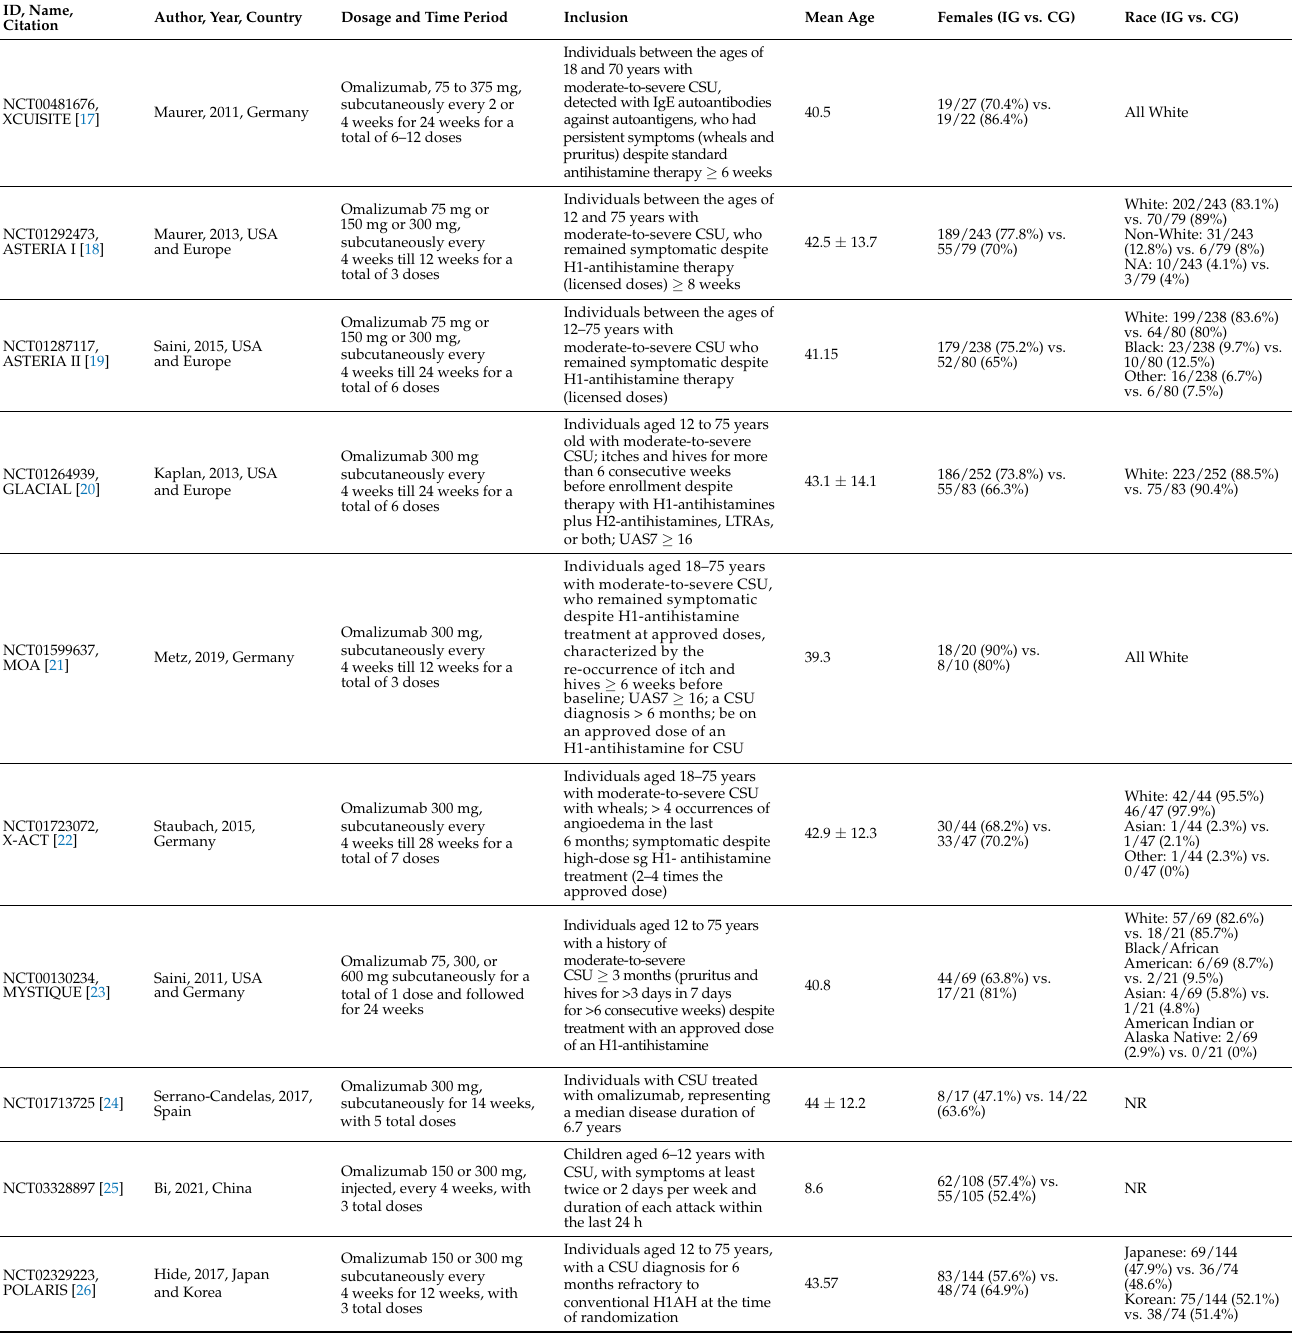
Table 1. Characteristics of Included